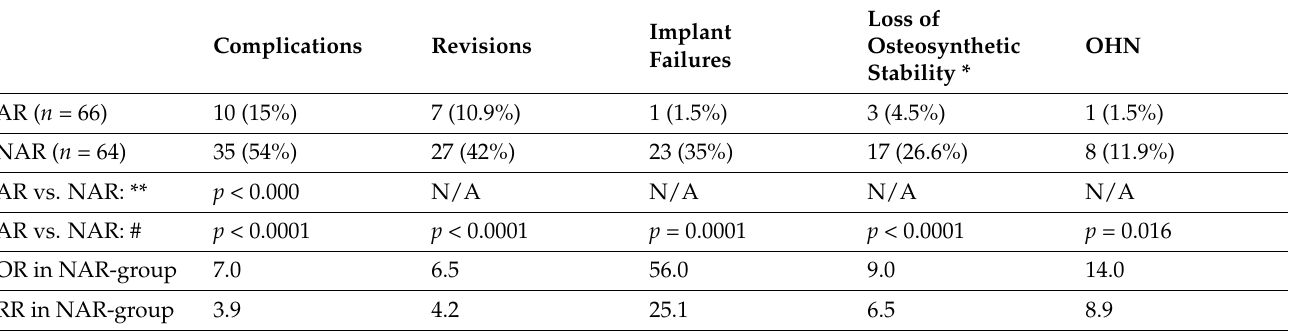
Table 5. Comparison of subgroups anatomical vs. non-anatomical reduction regarding complication, revision, and implant failure; AR = anatomical reposition; NAR = non-anatomical reposition; OR = odds ratio, RR = relative risk, OHN= osteonecrosis of the humeral